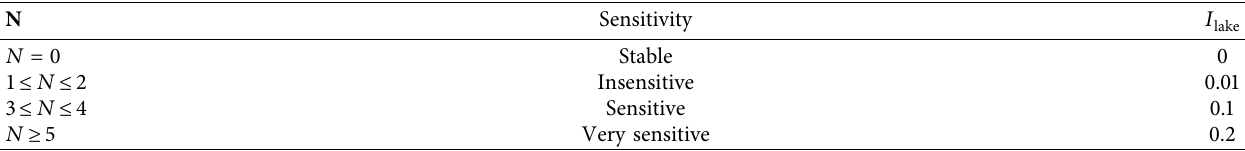
Table 4: The initial Activities of lake cells.